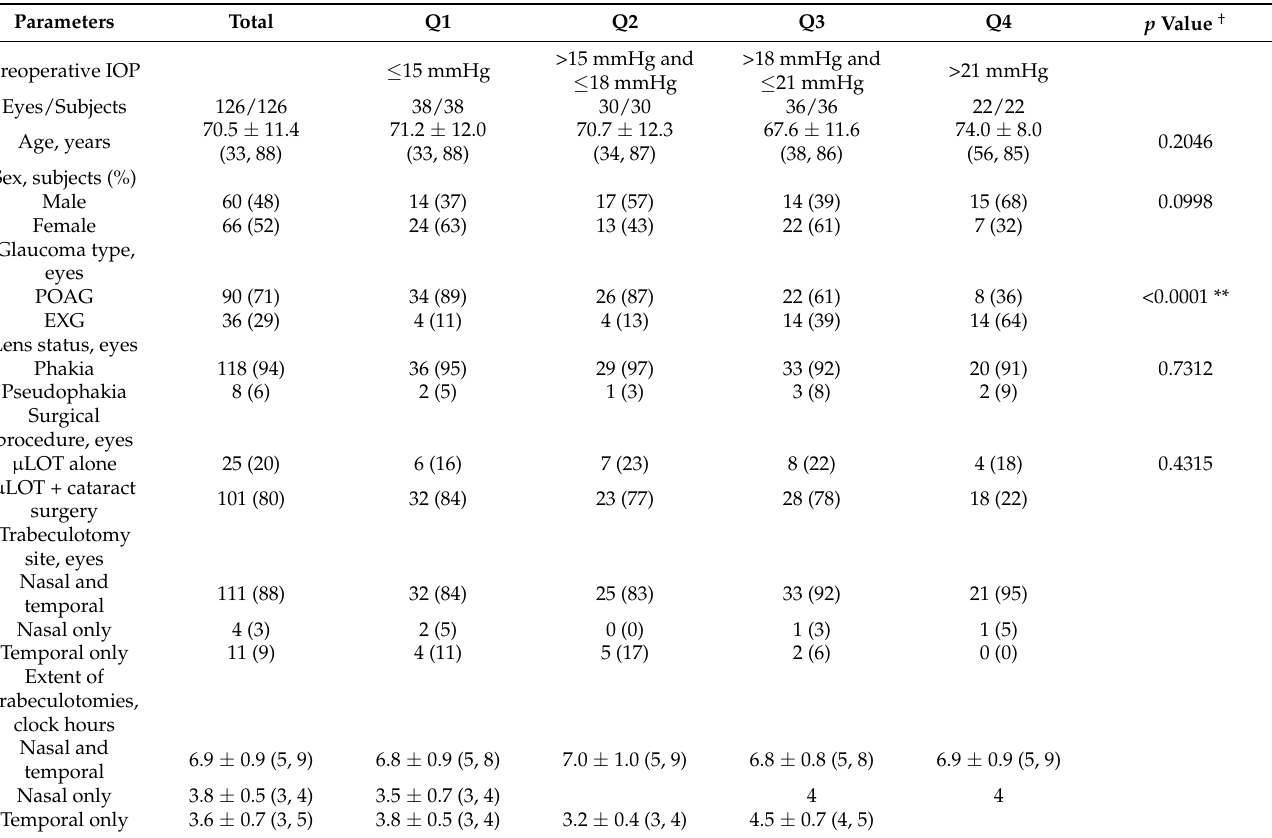
Table 1. Demographic patient